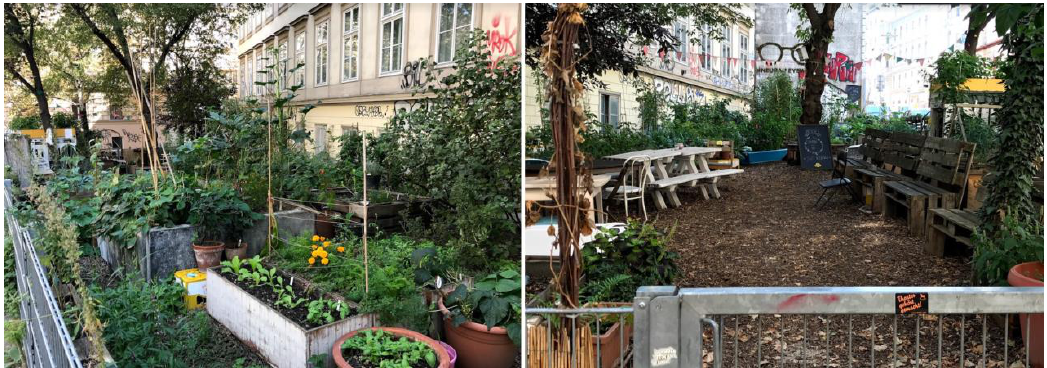
Figure 6. Salatpiraten community garden in Vienna, [photos by. A. Tofiluk — site visit (09.2018)].